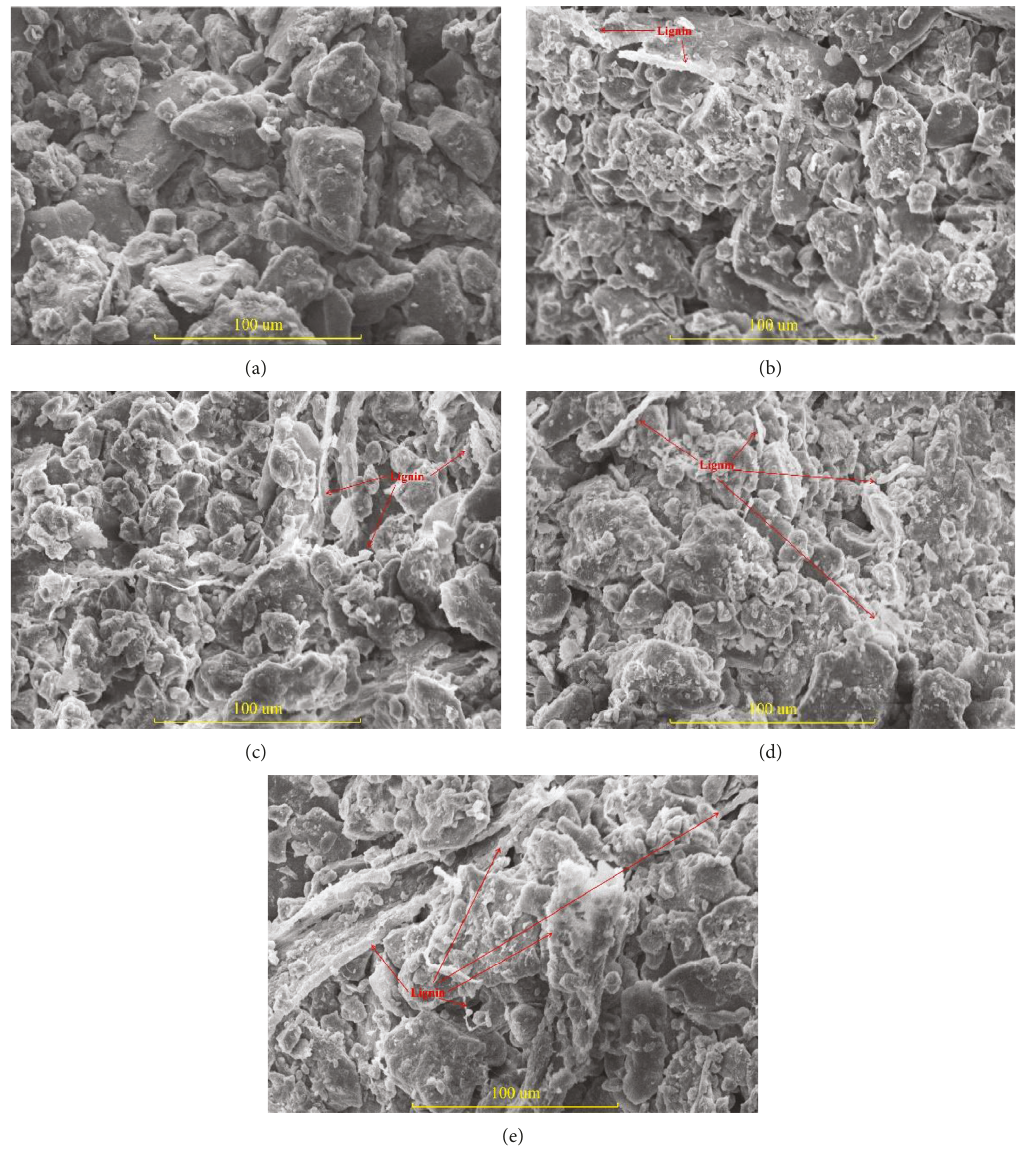
Figure 9: SEM results of treated loess with different contents of lignin. (a) MZS-0. (b) MZS-1. (c) MZS-2. (d) MZS-3. (e)